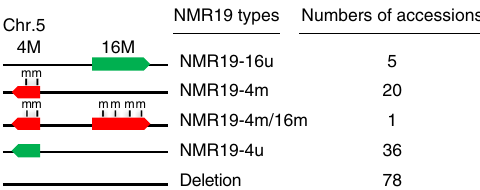
Fig. 3 Diversity in the methylation status and position of NMR19 in different Arabidopsis thaliana accessions. Classi fi cation of NMR19 according to their positions and methylation status. Left, black line represents chromosome 5 and “ 4M ” and “ 16M ” indicate the positions of NMR19 on this chromosome, and “ m ” indicates methylation of NMR19. Thus, there are fi ve different NMR19 types: NMR19-16u, NMR19-4m, NMR19-4m/16 m, NMR19-4u, and deletion. Right column shows the number of accessions with the corresponding NMR19